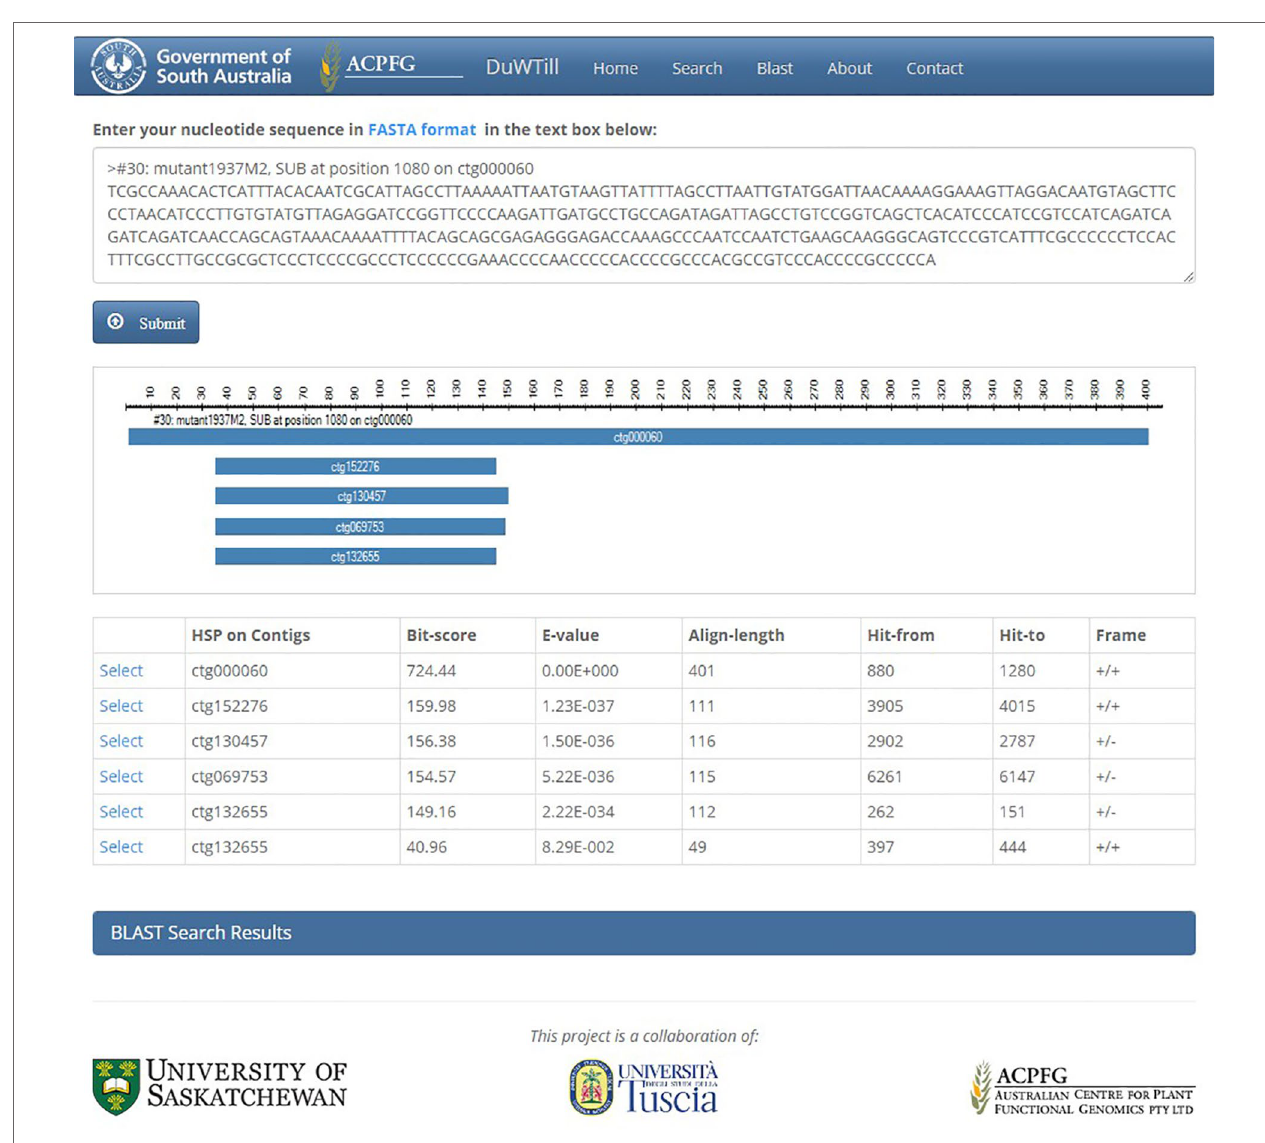
FIGURE 4 | BLAST page showing the results of a BLASTn search query in DuWTill. BLASTn search was executed using the same sequence that was presented in the table of Figure 3 . Top hits to DECaR are shown in two views: alignment overview and hit table. Detailed HSP alignments are reported in the additional expandable panel “BLAST Search